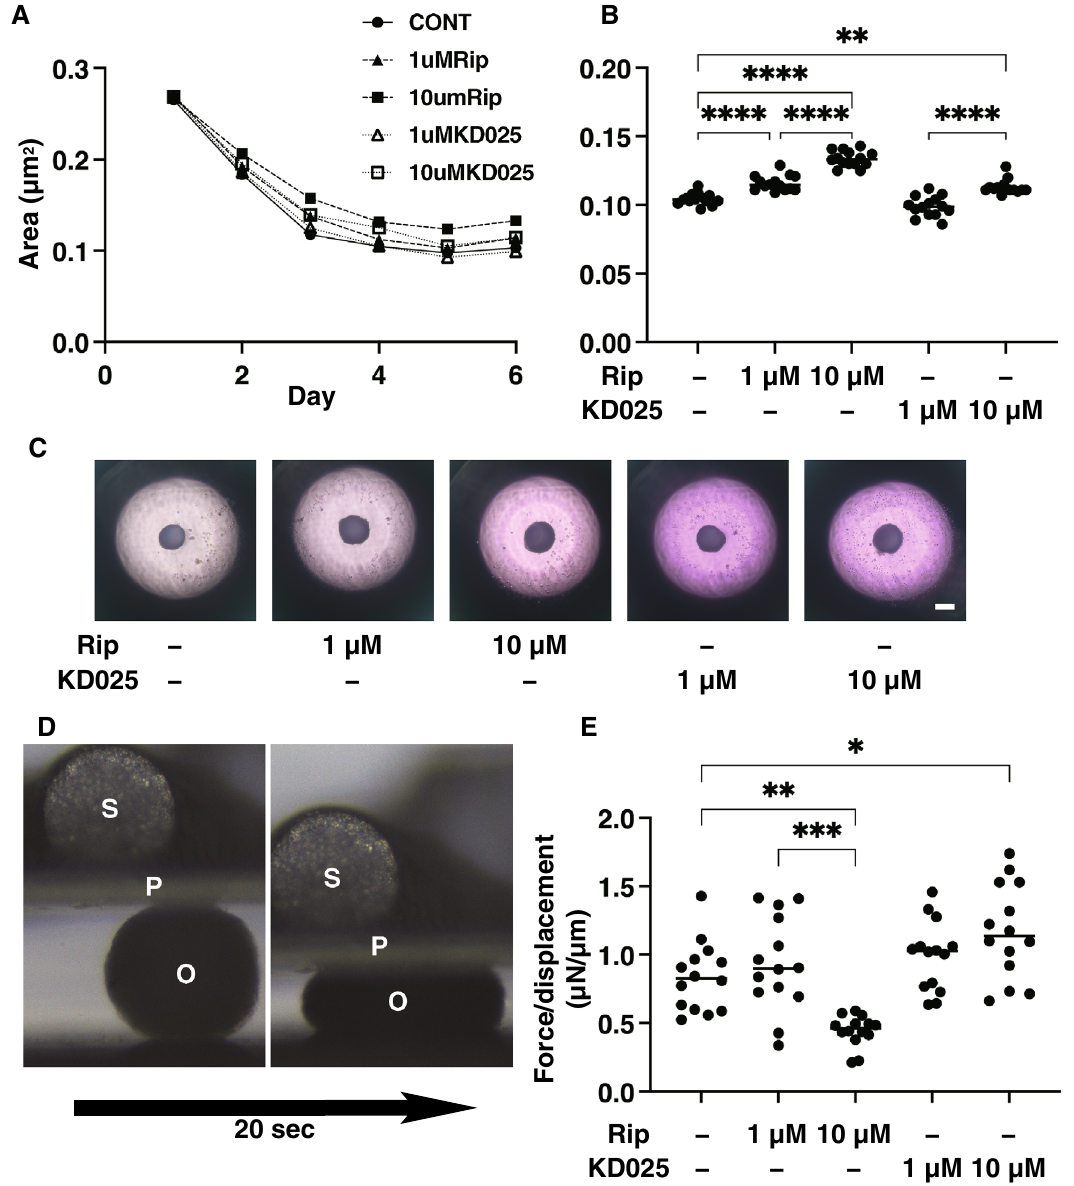
Figure 3. Effects of ROCK-is on physical properties, the mean sizes and stiffness of 3D spheroids of human corneal stroma fibroblasts (HCSFs) in the presence of ROCK inhibitors. In the absence or presence of 1 μM or 10 μM ROCK-is, ripasudil (Rip), or KD025, the mean sizes of 3D HCSFs spheroids were measured in triplicate using fresh preparations consisting of 16 organoids each during the 6-day culture period were plotted ( A ) and those at Day 6 were compared among the experimental groups ( B ), and phase contrast images are shown ( C ). Alternatively, using a micro-squeezer, the physical stiffness of a single living 3D HCSFs spheroid at Day 6 was measured during a 20 s period ( D , O; 3D spheroid, P; compressing plate, S; pressure sensor) in the absence or presence of 1 μM or 10 μM ROCK-is, ripasudil (Rip) or KD025 (n = 15–20 freshly prepared 3D spheroids under each experimental condition). The force (μN) required to induce a 50% deformity was calculated and force/ displacement (μN/μm) values were plotted in ( E ). Data are presented as the arithmetic mean ± standard error of the mean (SEM). * P < 0.05, ** P < 0.01, *** P < 0.005, **** P < 0.001 (ANOVA followed by a Tukey’s multiple comparison